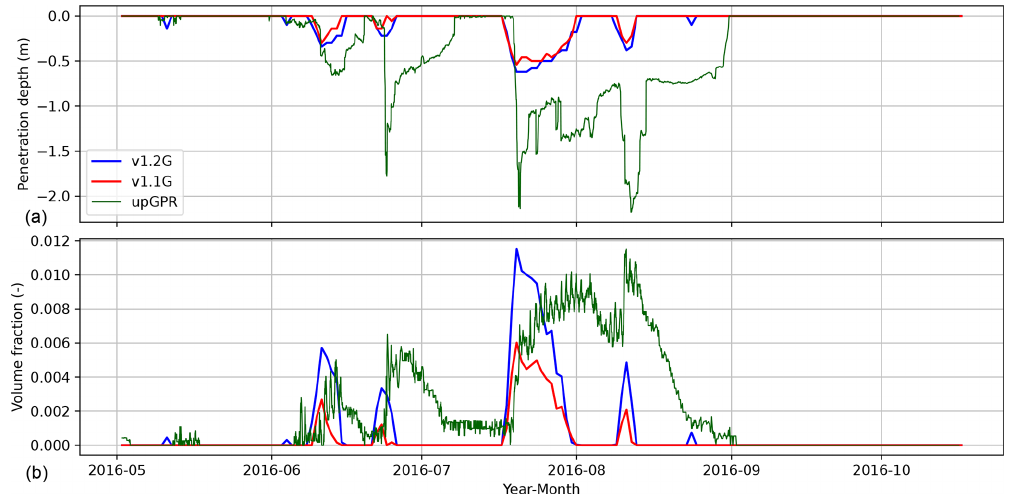
Figure 9. Comparison between the observed penetration depth (a) and volume fraction (b) of liquid water at Dye-2 with the results from v1.1G and v1.2G. Table 2. Location and climate of the three case study sites. The annual mean accumulation is calculated over the whole simulation period (1957–2020). Long. Lat. Elevation T 2m Acc. (mmw . e .